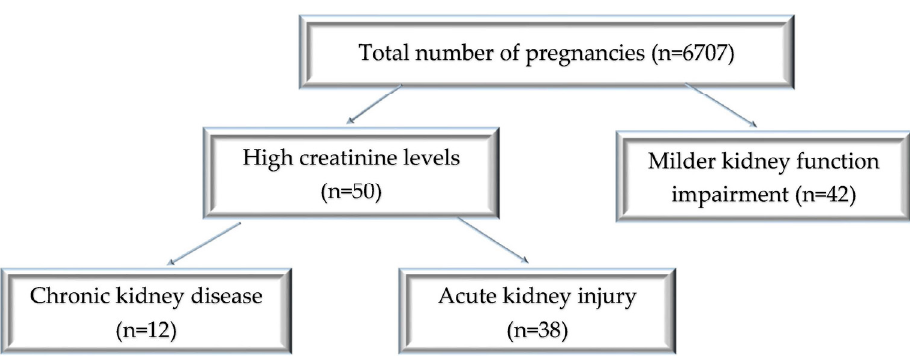
Figure 1. Diagram of patient distribution according to the type of renal injury and the values of creatinine levels.